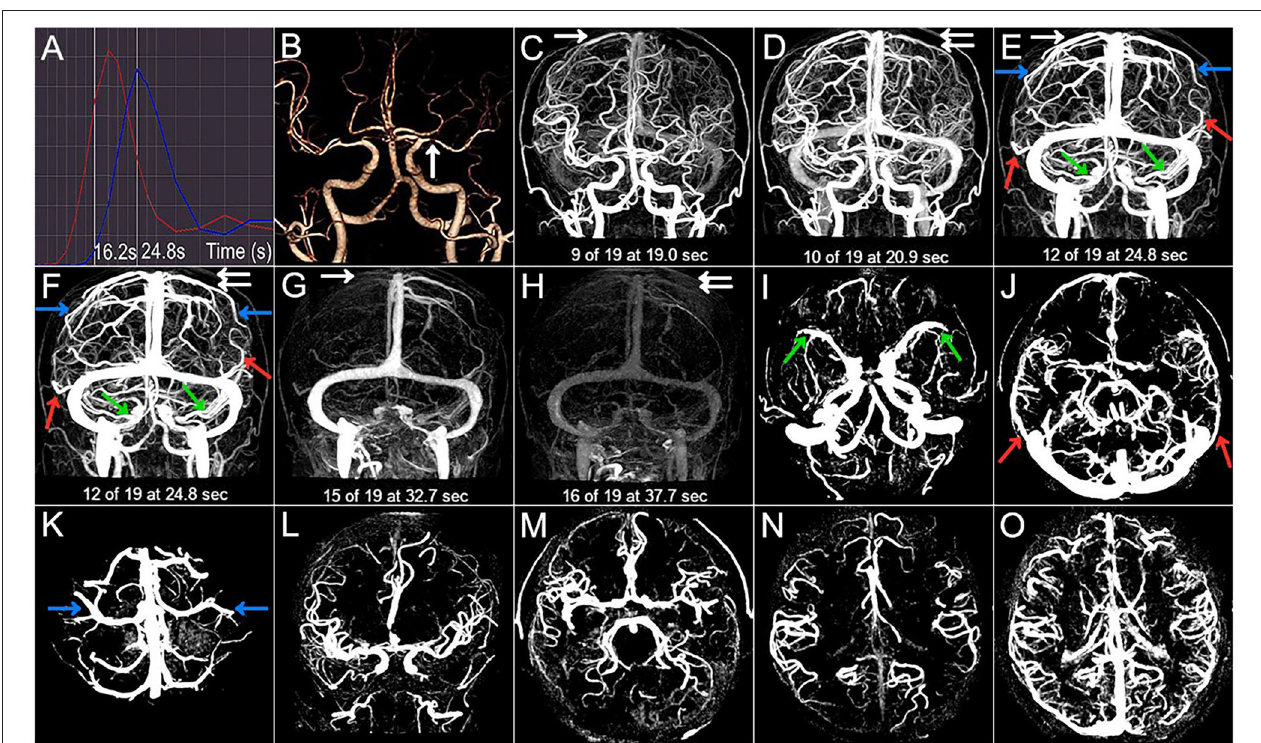
FIGURE 1 | Case 1. A 66-year-old man with a history of hypertension and lipid disorder presented with dizziness for 3 days. (A) The arterial and venous time attenuation curves (TACs; red and blue, respectively). The selected arterial phase on TAC (A-TAC) was 16.2s, and the time-to-peak on the venous TAC (V-TAC) was 24.8s. (B) The arrow points to the left MCA M1 severe stenosis at A-TAC on three-dimensional (3D) computed tomographic angiography (CTA). (C–H) The 3D computed tomography venography (CTV) shows cortical venous filling (CVF) draining into the superior sagittal sinus at early (CVF 1 ), peak (CVF 2 ), and late venous phases (CVF 3 ) in the affected (double white arrow) and contralateral (white arrow) hemispheres. Cortical veins begin to be visible in the contralateral (C, CVF 1 , 19.0s) and affected hemispheres (D, CVF 1 , 20.9s). The maximum contrast opacification of all cortical veins in the contralateral (E, CVF 2 , 24.8s) and affected hemispheres (F, CVF 2 , 24.8s) appear at the same time, and contrast medium in all cortical veins disappears in the contralateral (G, CVF 3 , 32.7s) and affected hemispheres (H, CVF 3 , 37.7s). CVF 21 and CVF 31 of the contralateral hemisphere are 5.8s and 13.7s, respectively, while the CVF 21 and CVF 31 of the affected hemisphere are 3.9s and 16.8s, respectively. The mean difference between the affected and contralateral hemispheres is 1.9s for rCVF 1 , 0s for rCVF 2 , 5s for rCVF 3 , − 1.9s for rCVF 21 , and 3.1s for rCVF 31 . The presence (color arrow) and absence (circle) of SMCV (green), VOL (red), and VOT (blue) across all whole venous phases (marked as SMCV + /VOL + /VOT + and SMCV-/VOL-/VOT-, respectively) are displayed in the 3D CTV and (I–K) axial planes of the V-TAC. SMCV-, VOL-, and VOT- are not found in the bilateral hemispheres. (L,M) Antegrade flow assessment at TAC in the coronal and axial planes. Contrast filling of the MCA M1 segment and its distal branches in the affected hemisphere is more than two-thirds of the contralateral hemisphere. the contralateral hemisphere, and antegrade flow is preserved. (N,O) Collateral status assessment at A-TAC and V-TAC in the axial plane. Complete contrast enhancement of collateral flow at V-TAC in the affected hemisphere with good collateral